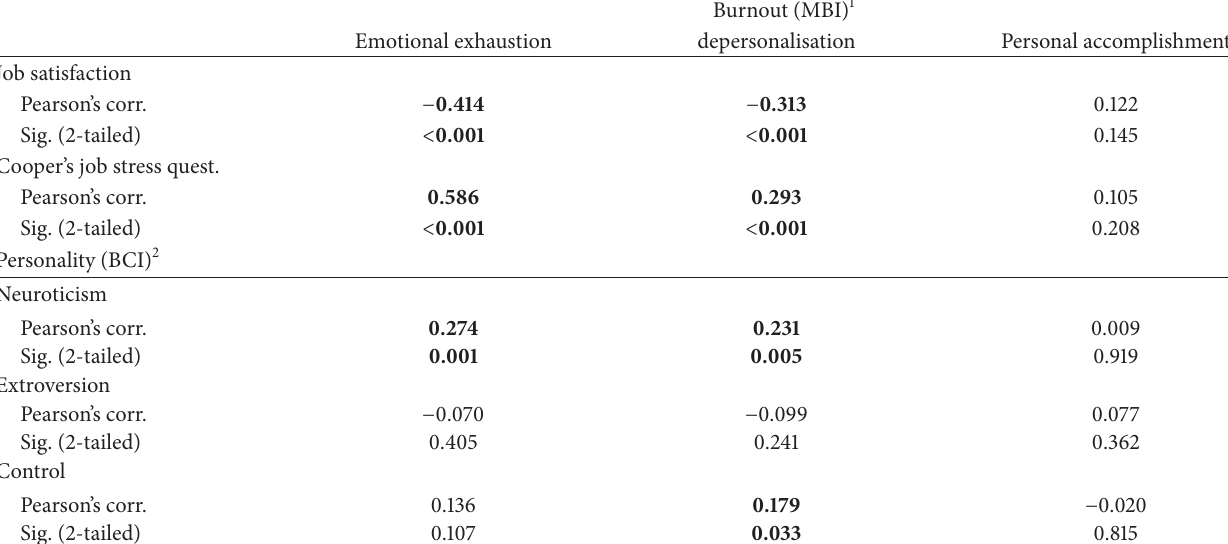
Table 3: Associations between burnout and job satisfaction, job stress, and